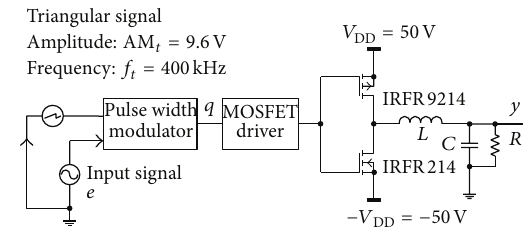
Figure 3: The circuit of half-bridge